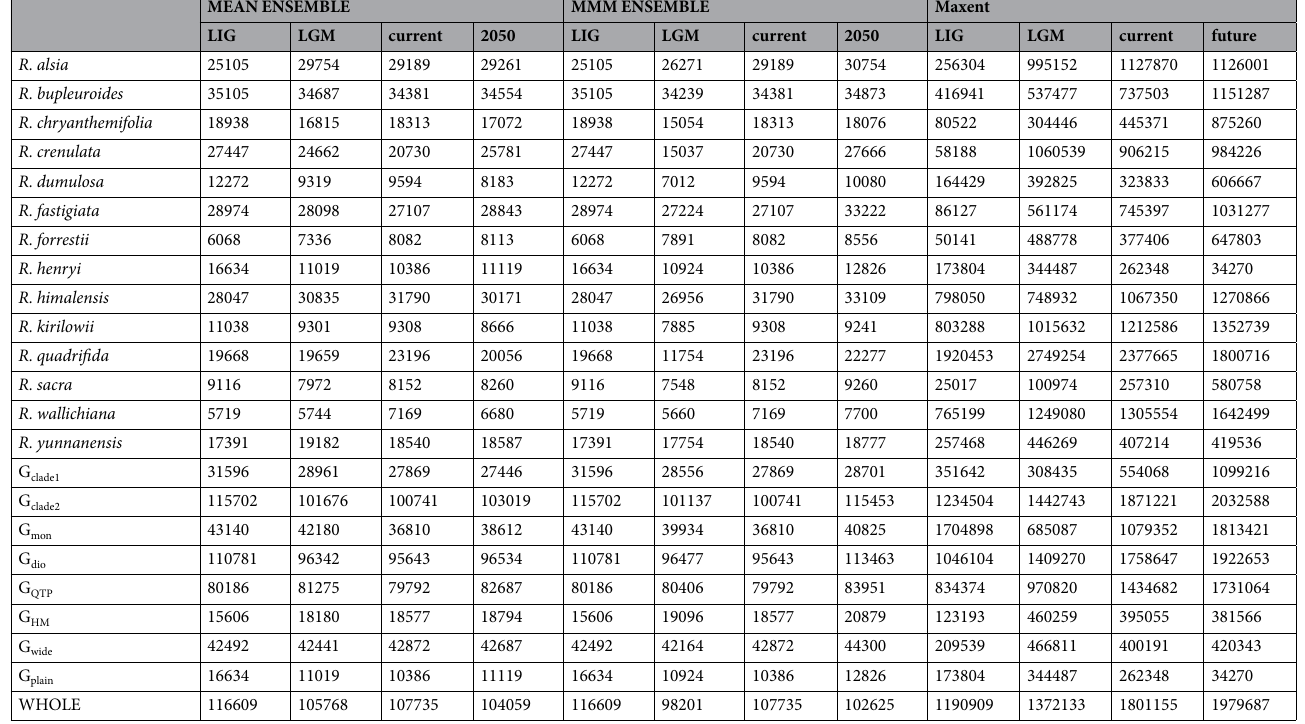
Table 2. Predicted suitable area (km 2 ) of Rhodiola species and species groups for each time period using MEAN ENSEMBLE, MMM ENSEMBLE and